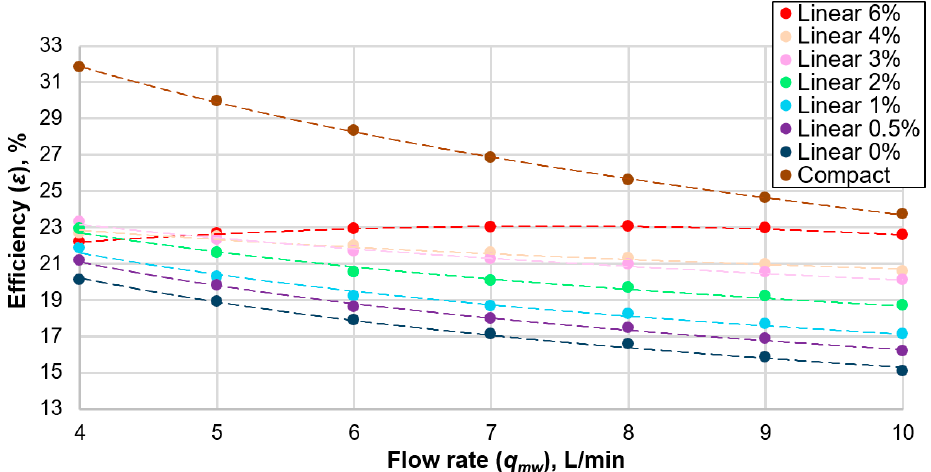
Figure 5. Efficiency of the shower heat exchangers determined for T cw = 10 °C.